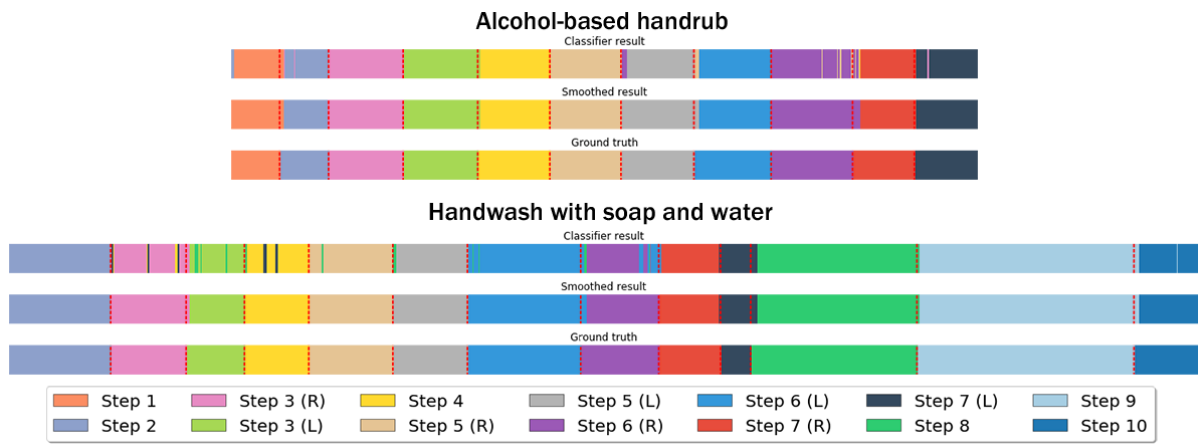
Figure 9. Visualization of how classification and smoothing work for handrub (top) and handwash (bottom). The steps are in accordance with Table